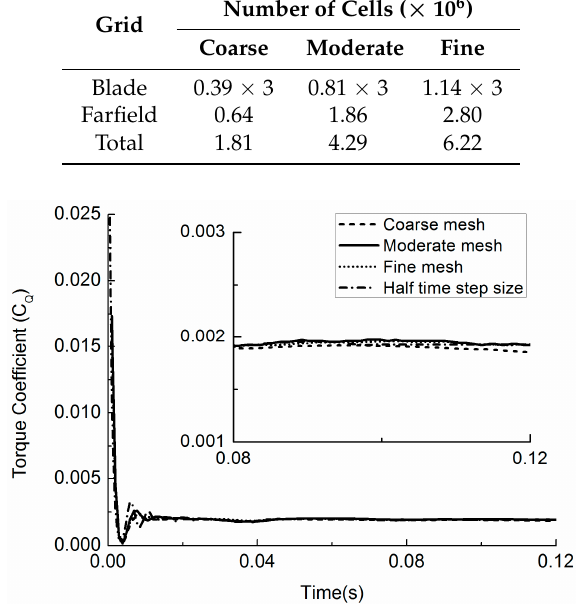
Figure 5. Rotor torque coefficient obtained with three resolution grids and half time step size. Table 4. Value and relative error of the torque coefficient (C Q ) at the final steady state.